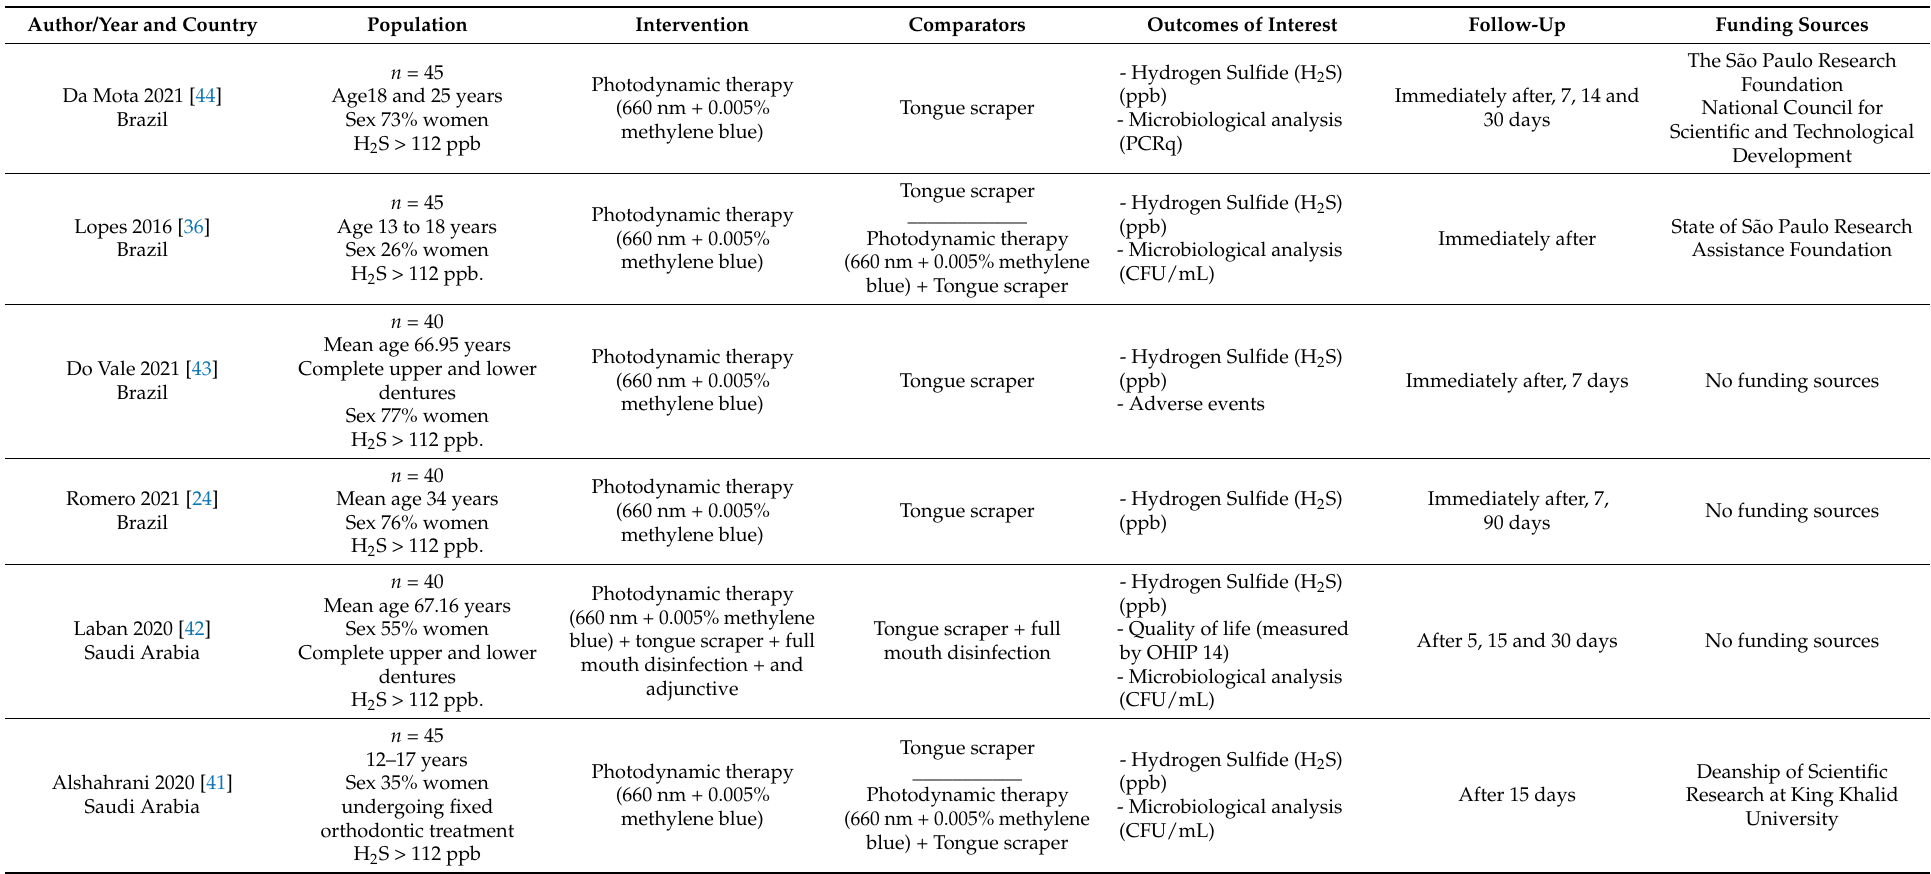
Table 1. Main characteristics of included